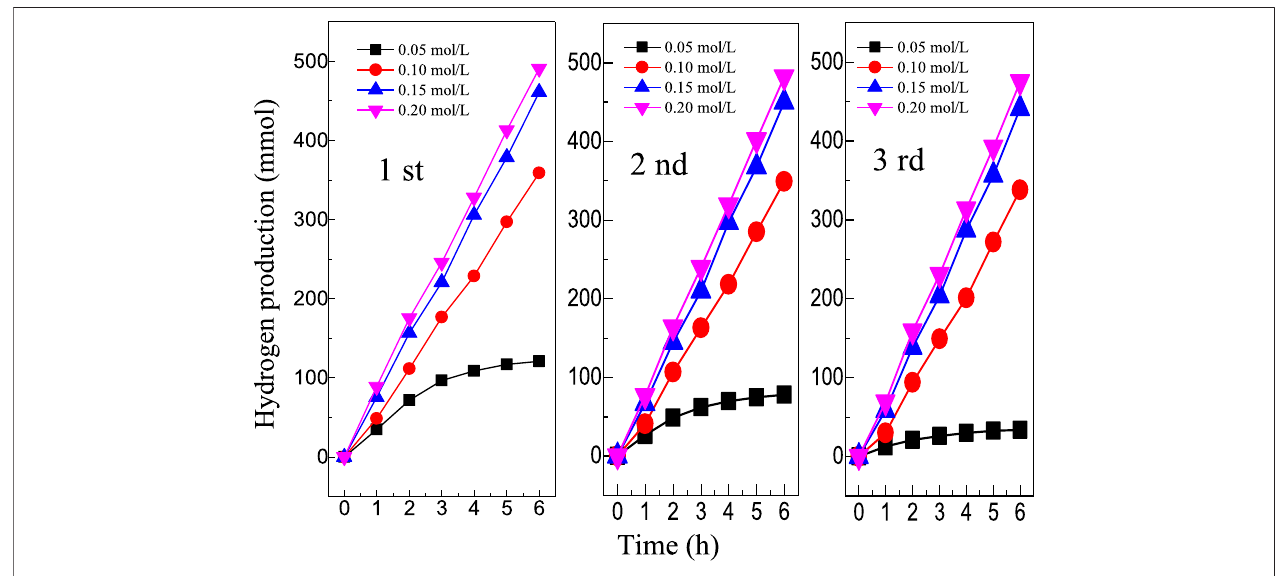
FIGURE8| HydrogenevolutionofMoS 2 /Ccompositespreparedbythehydrothermalcalcinationmethodwiththedifferentconcentrationsofmolybdenumchloride including 0.05, 0.10, 0.15, and 0.20 mol/L under visible light irradiation for three